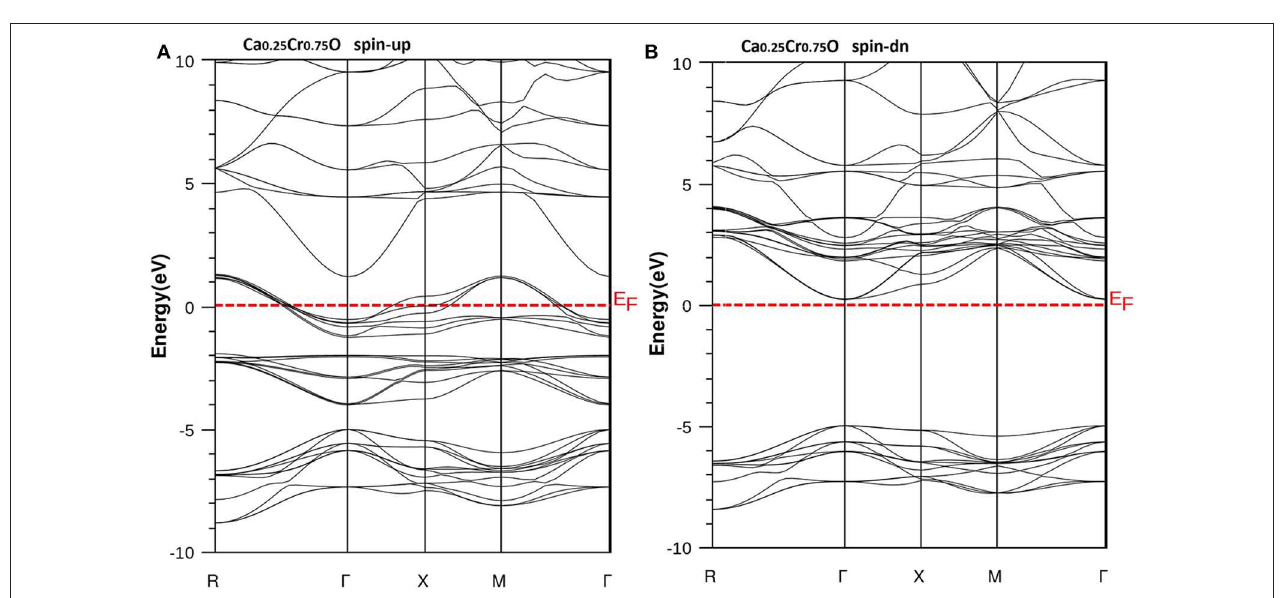
FIGURE 7 | Band structures of Ca 0.25 Cr 0.75 O. (A) Majority spins ( up ) and (B) minority spins ( dn ). The Fermi level is set to zero ( horizontal dotted line ).